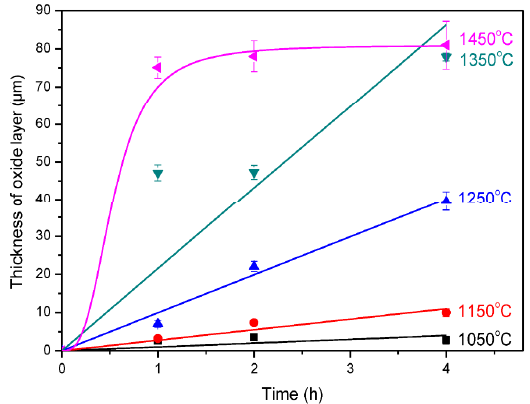
Fig. 4 Thickness of the oxide layer as a function of oxidation time at various temperatures. The thickness was estimated from the oxygen maps shown in Fig.